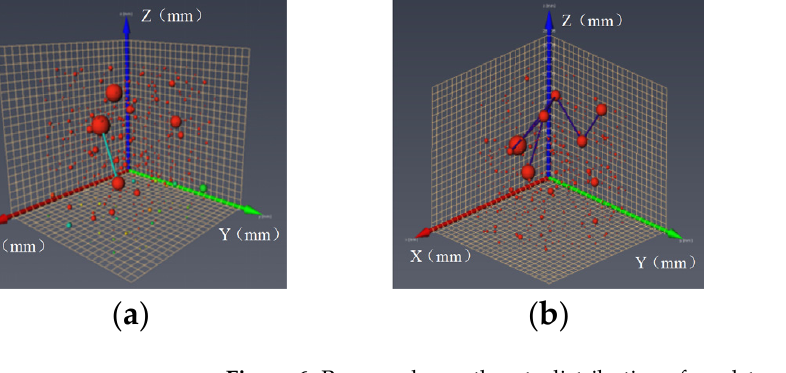
Figure 6. Pores and pore throats distribution of mudstone in the third loading stage. ( a ) First loading stage. ( b ) Second loading stage. ( c ) Third loading stage.